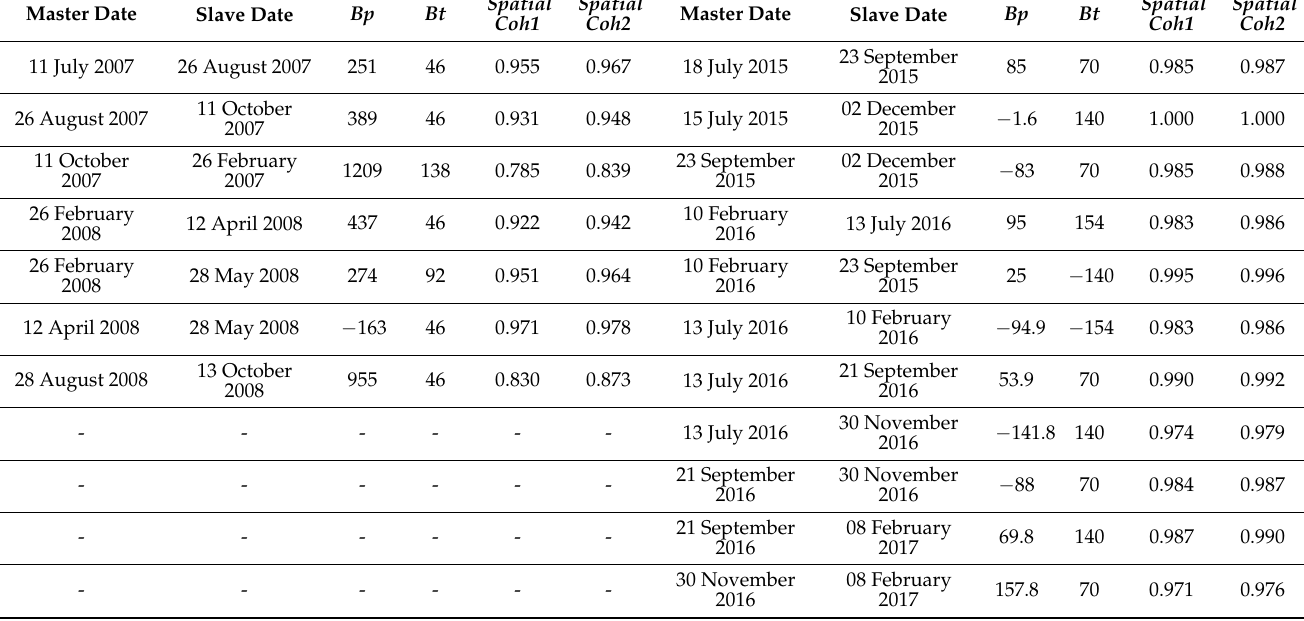
Table 1. Employed PALSAR 1 (left part)/2 (right part) InSAR pairs and their acquisition conditions together with spatial phase coherences ( Bp : perpendicular baseline (m), Bt : temporal baseline (day), Spatial coh1 : spatial phase coherences in mean topographic slope angle (3.34 ◦ ). Spatial coh2 : spatial phase coherences in mean topographic slope angle (28.3 ◦ ). The samples of topographies to calculate Spatial coh1 and 2 were taken from a low sloped plain and high-relief dune field.